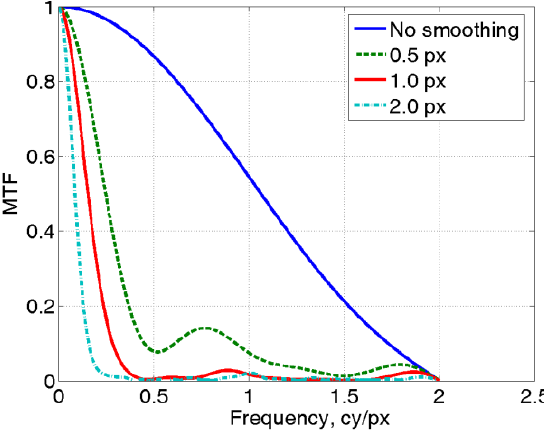
Figure 12. Plot of MTF related to the four simulated cases described in Figure 11.